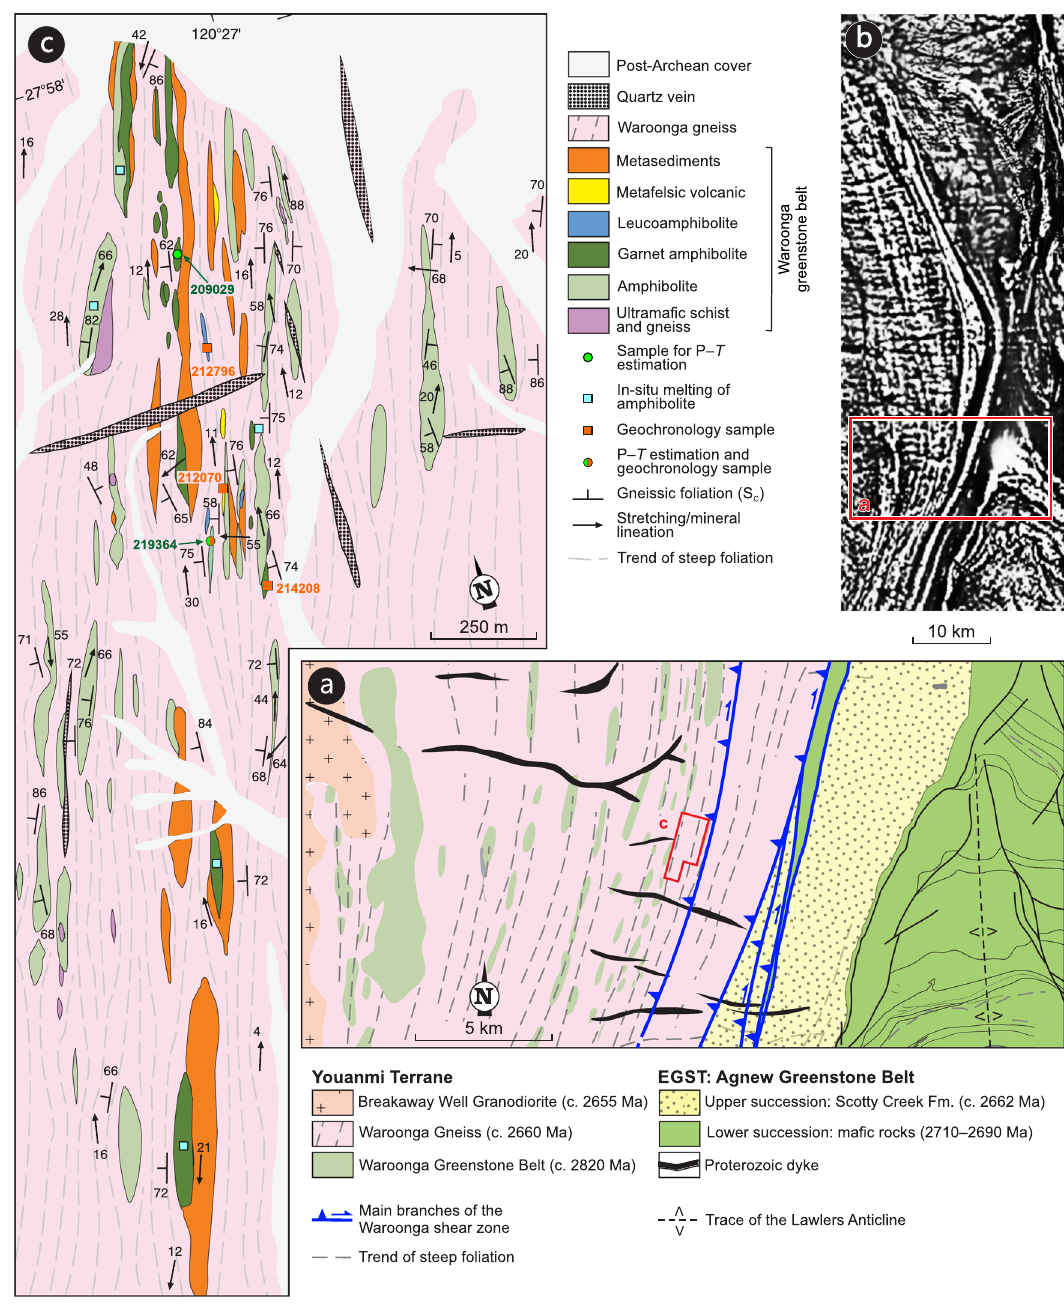
Fig. 3 | Geological maps of the Waroonga shear zone. a Geological map of the study area, across the central portion of the Waroonga shear zone (Fig. 1c for location). The rectangleshowsthe location of the map shown inpanel c . b Merged magnetic anomaly map of the Waroonga shear zone, as part of the magnetic anomalygrid(40m)ofWesternAustralia,Version1 – 2013.Thefullmapisavailable